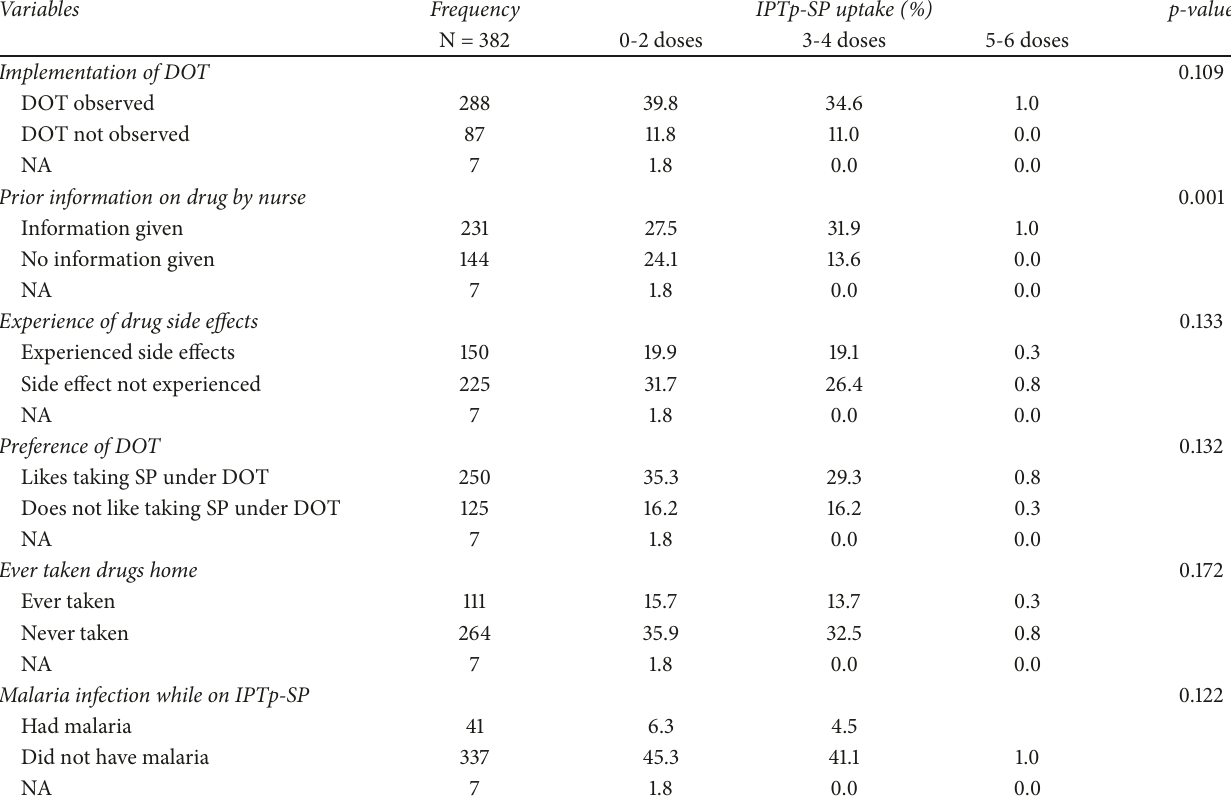
Table 3: Implementation of DOT, drug side effects, and IPTp-SP uptake.